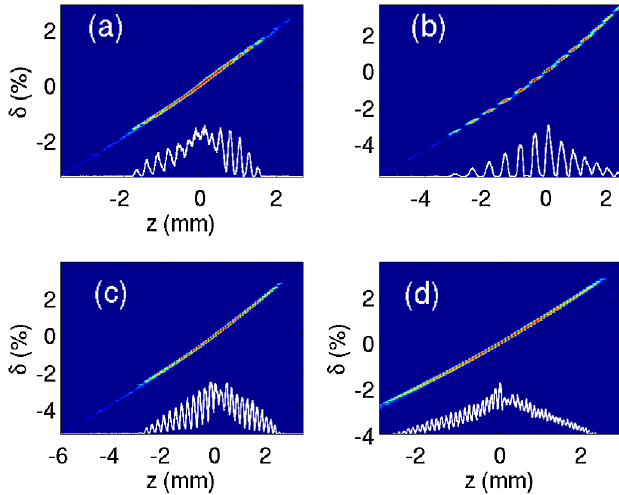
FIG. 11. Example of generation of modulated longitudinal trace space downstream of the EEX beam line. The four plots correspond to the four cases of initial parameters ð (cid:2)w; w; F Þ of (100, 300, 0.92) [plot (a)], (100, 300, 1.25) [plot (b)], (50, 150, 0.75) [plot (c)], and (25, 75, 0.75) [plot (d)], where (cid:2)w and w are, respectively, the slit edge-to-edge separation and width in micro- meters, and F is a scaling factor for the quadrupoles Q1, Q2, Q3, and Q4 (when F ¼ 1 the quadrupoles are tuned to match the Þ ¼ ð 2 ; 12 m Þ upstream of ; (cid:1) horizontal C-S parameter to ð (cid:3) x; 0 x; 0 the exchanger).